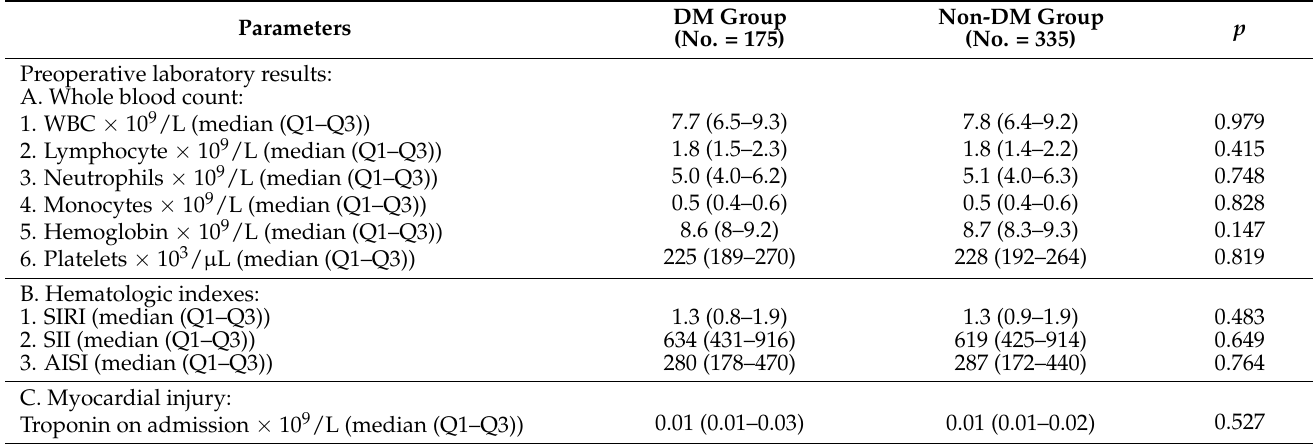
Table 2. Laboratory results: comparison between both groups (DM vs.